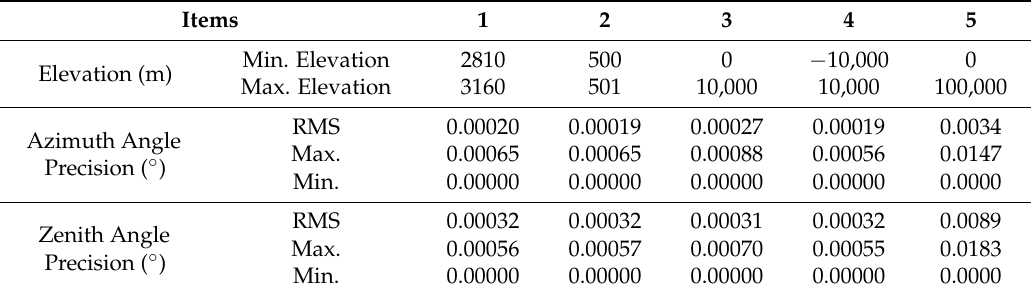
Table 1. Precision of Gaofen-1 (GF-1) Wide Field-of-View-1 (WFV-1) viewing angles calculated from the Rational Function Model (RFM) at planes of different